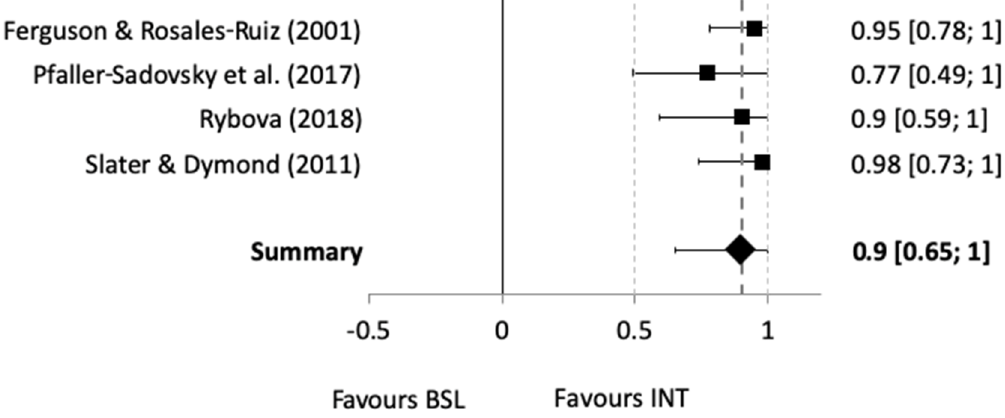
Figure 3. Forest plot featuring the studies MBL studies with respective Tau-U effect sizes. The diamond-shaped data point at the bottom of the plot represents the mean or summary effect size across all four studies. Note: BSL = baseline; INT = intervention .